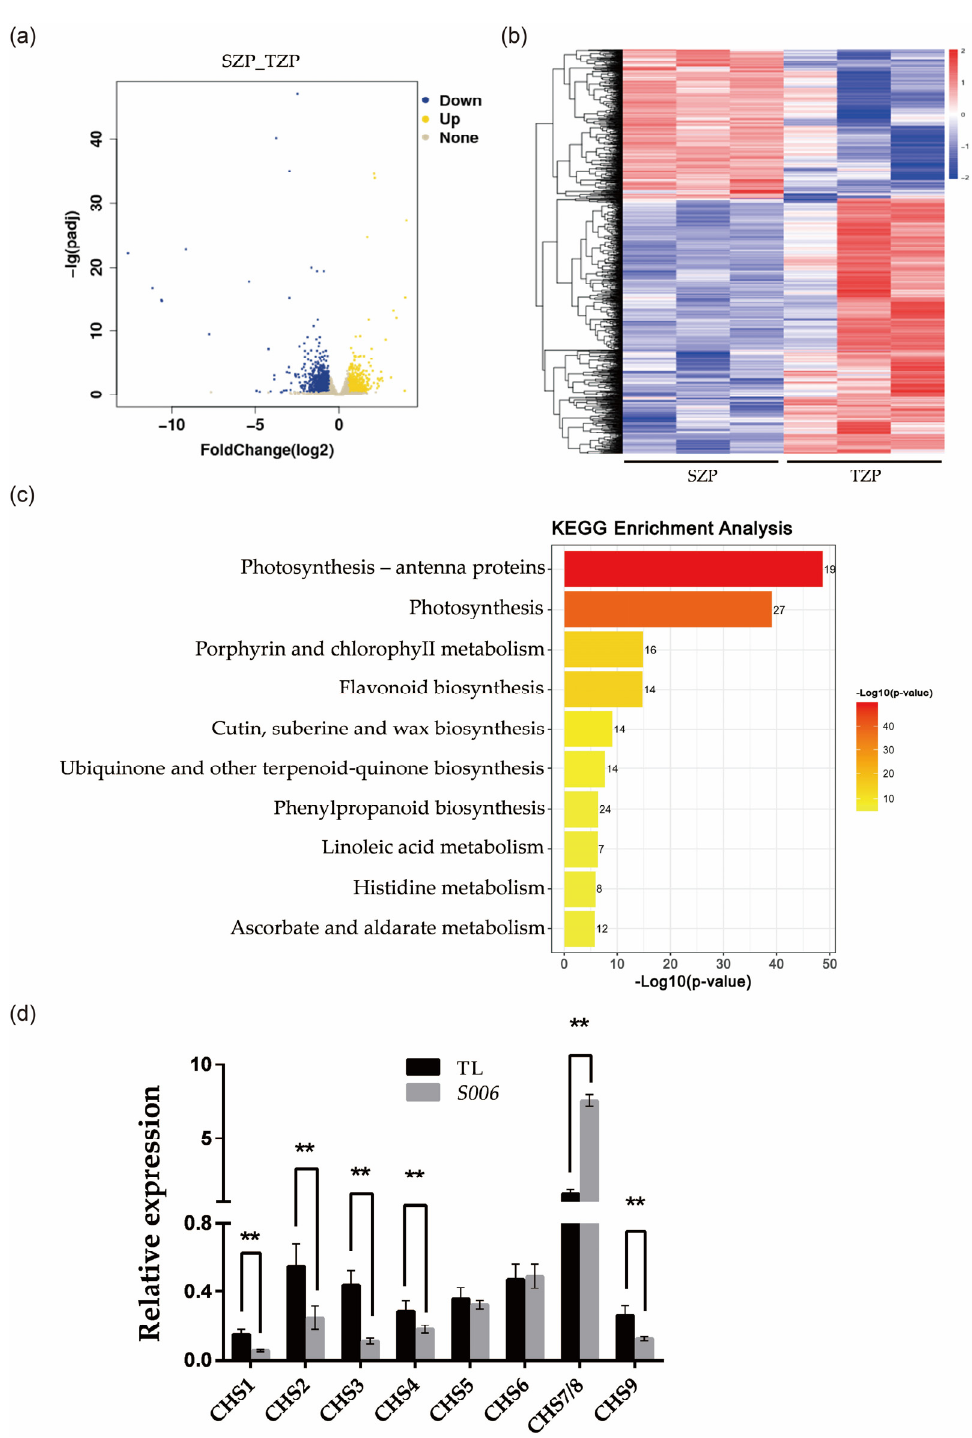
Figure 4. Transcriptome analysis of S006 and wild type. ( a ) A volcano plot of DEGs between S006 and wild type; ( b ) a heat map of DEGs between S006 and wild type; ( c ) the ten KEGG pathways that were the most enriched in DEGs ; ( d ) the RT-qPCR verified the expression of nine CHS genes. Asterisks indicate a significant difference according to Student’s t -test (**, p < 0.01).